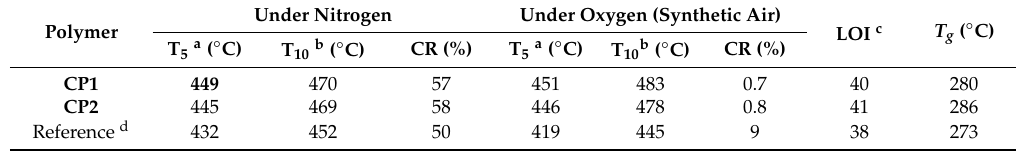
Table 4. Thermal TGA data of the polymers in an inert (N 2 ) and an oxidizing (synthetic air) atmosphere.